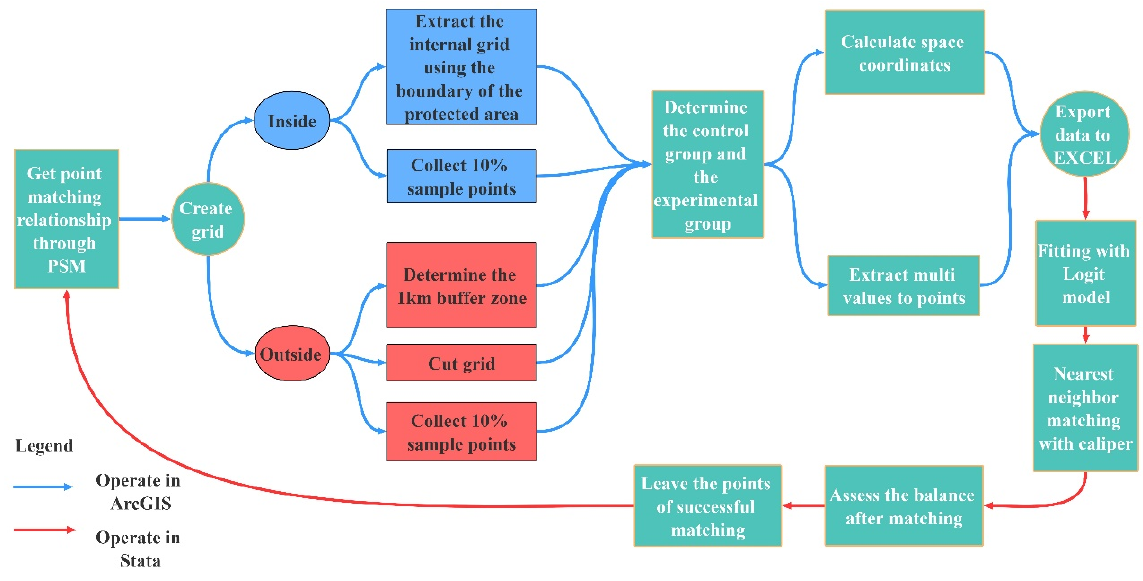
Figure 2. PSM technical